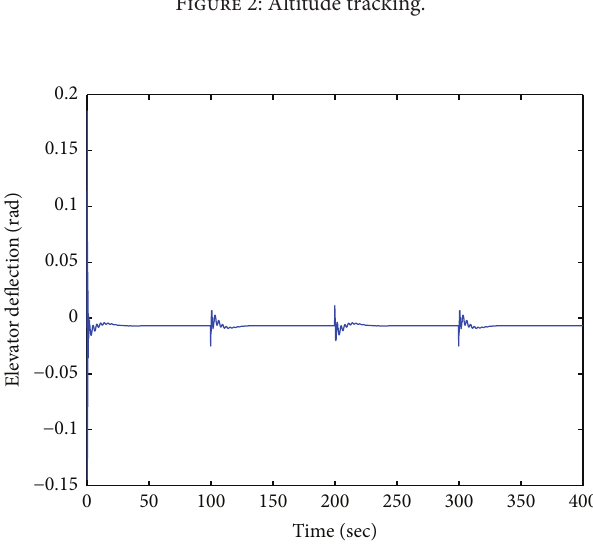
Figure 3: Elevator deflection.